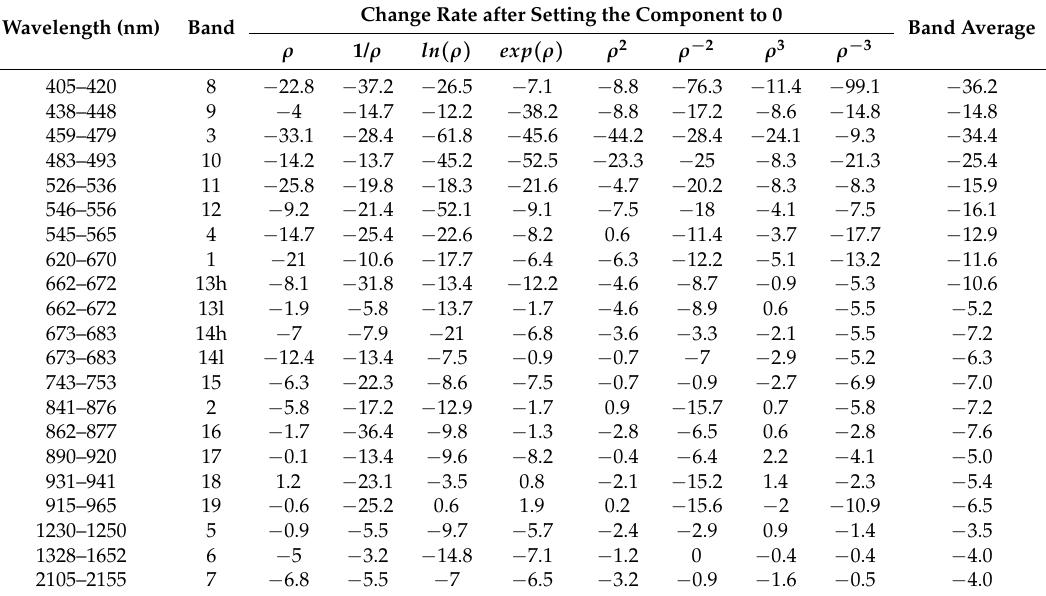
Table 4. Band sensitivity to TP concentration in Lake